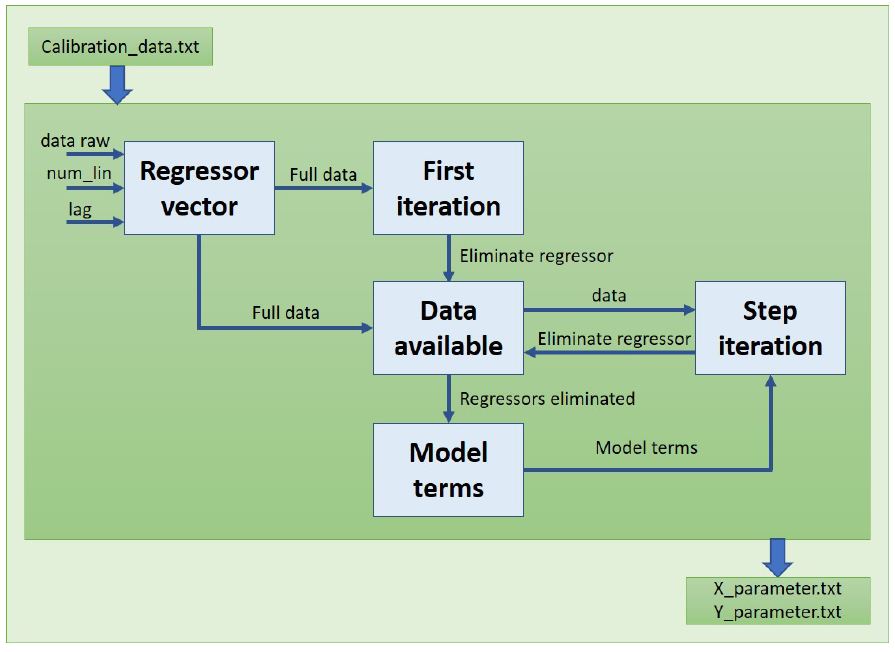
Figure 3. Nonlinear calibration script